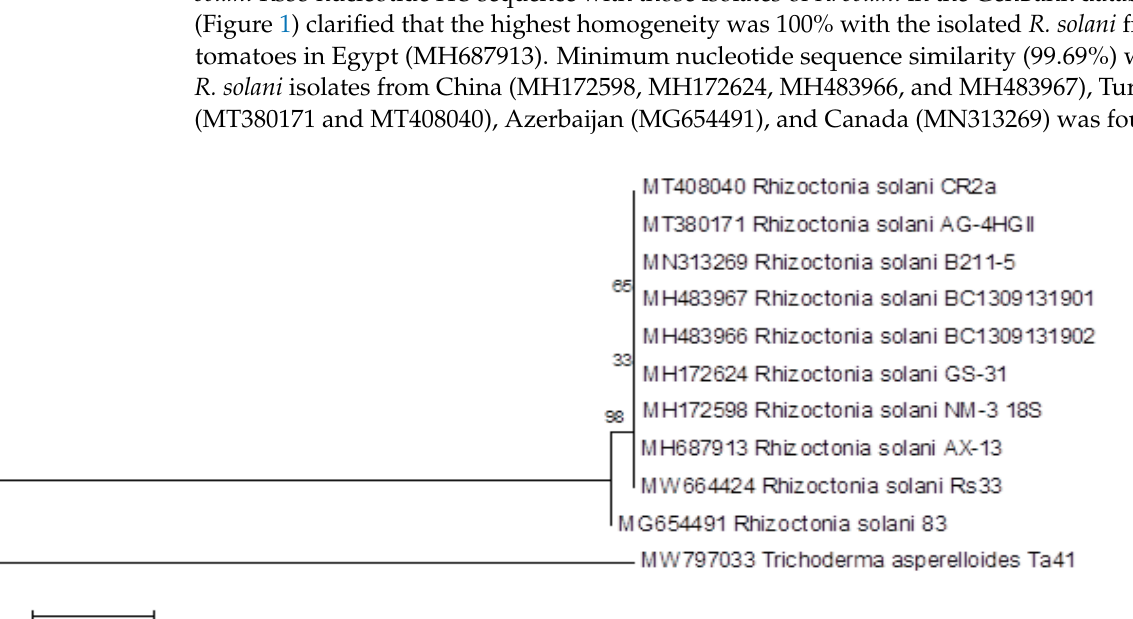
Figure 1. A phylogenetic diagram, degenerated by the neighbor-joining method showing the relationship between the R. solani Rs33 isolate and other R. solani isolates based on ITS sequences available in GenBank (NCBI).